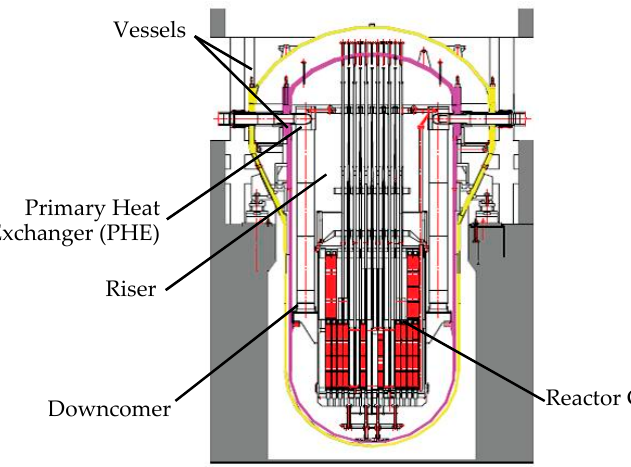
Figure 1. Schematic structure of nuclear heating reactor (NHR).